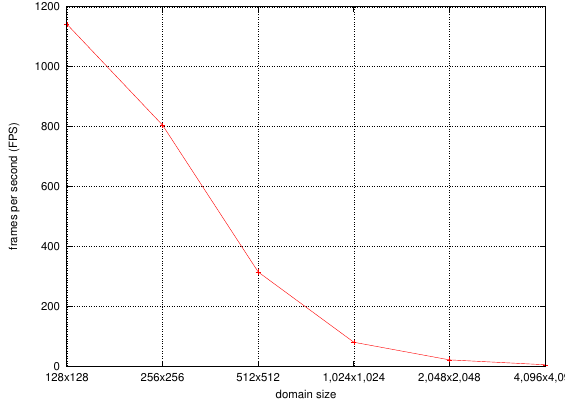
Fig. 11: Physics simulation FPS.